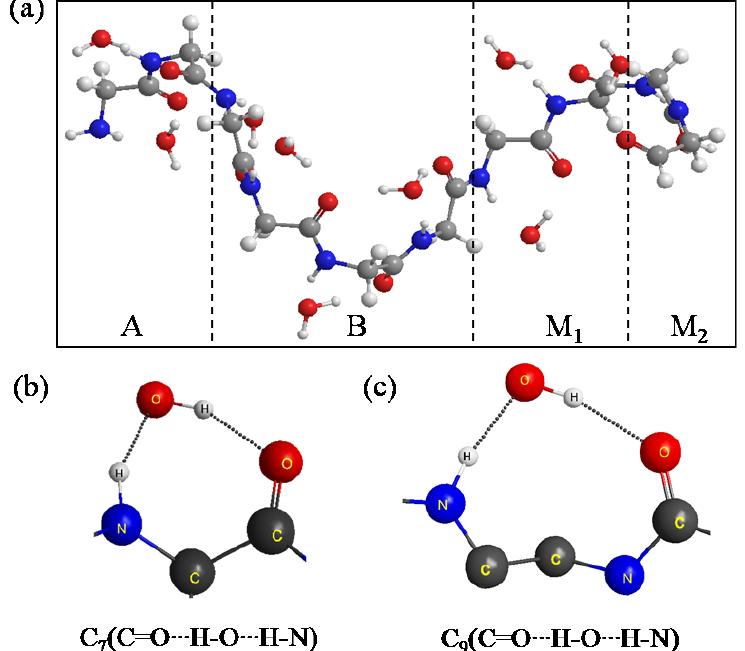
Figure 4. ( a ) The structure of the A, B, M conformation as the initial structure for ELG-MD simulation. Panels ( b ) and ( c ) show two types of H-bond ring. The dotted lines in the panels denote hydrogen